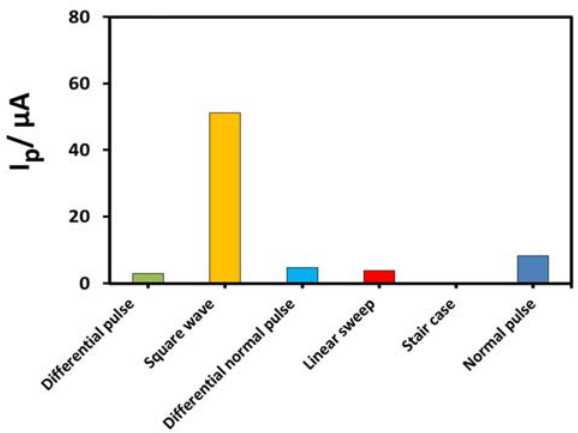
Figure 7: Histograms showing the effect of various voltammetric techniques at GPE surfaces on the detection of 6.2 × 10 –7 mol/L Hg(II) in 0.1 mol/L acetate buffer (pH 5.5). Working conditions: deposition potential –1.6 V, amplitude 0.06 V, frequency 100 Hz, deposition time 120